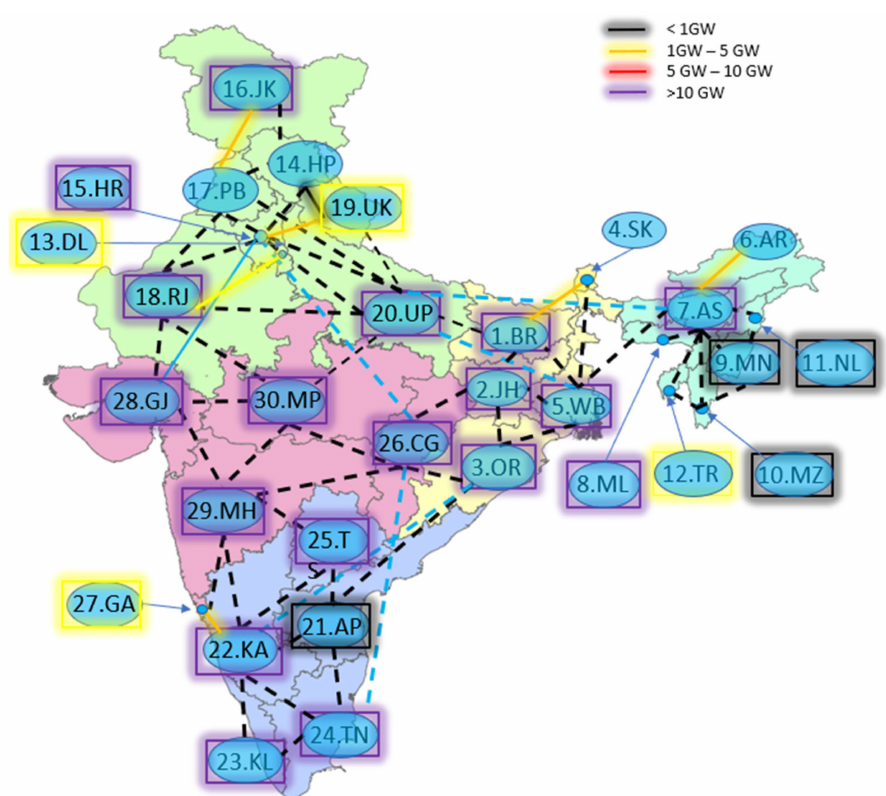
Figure 9. Aggregate investments in the transmission system of India as of 2050 (scenario-tree node 8) with the possibility to invest in conventional reinforcements and in energy storage. Dashed lines represent existing transmission lines, full lines represent transmission lines that are reinforced, and squares represent energy storage investment in the corresponding bus.